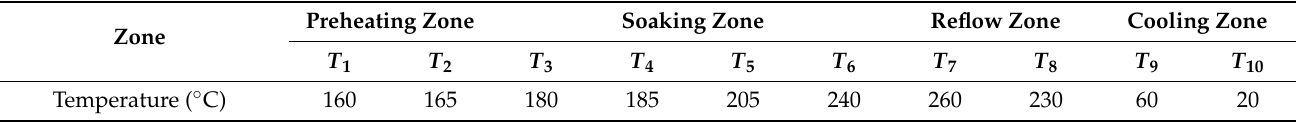
Table 3. Temperature setting in different